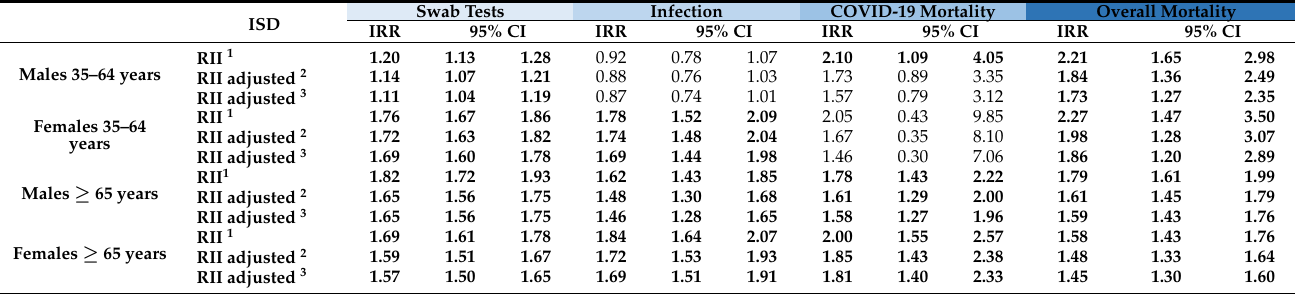
Table A3. Relative Index of Inequality (RII) about access to swabs, SARS-CoV-2 confirmed infection and for COVID-19 and all-causes mortality by individual Index of Socioeconomic Disadvantage, gender, and age